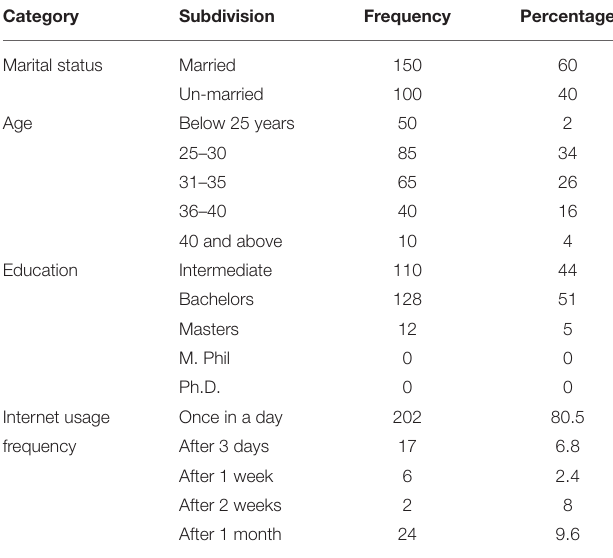
TABLE 1 | Demographic profiles of the